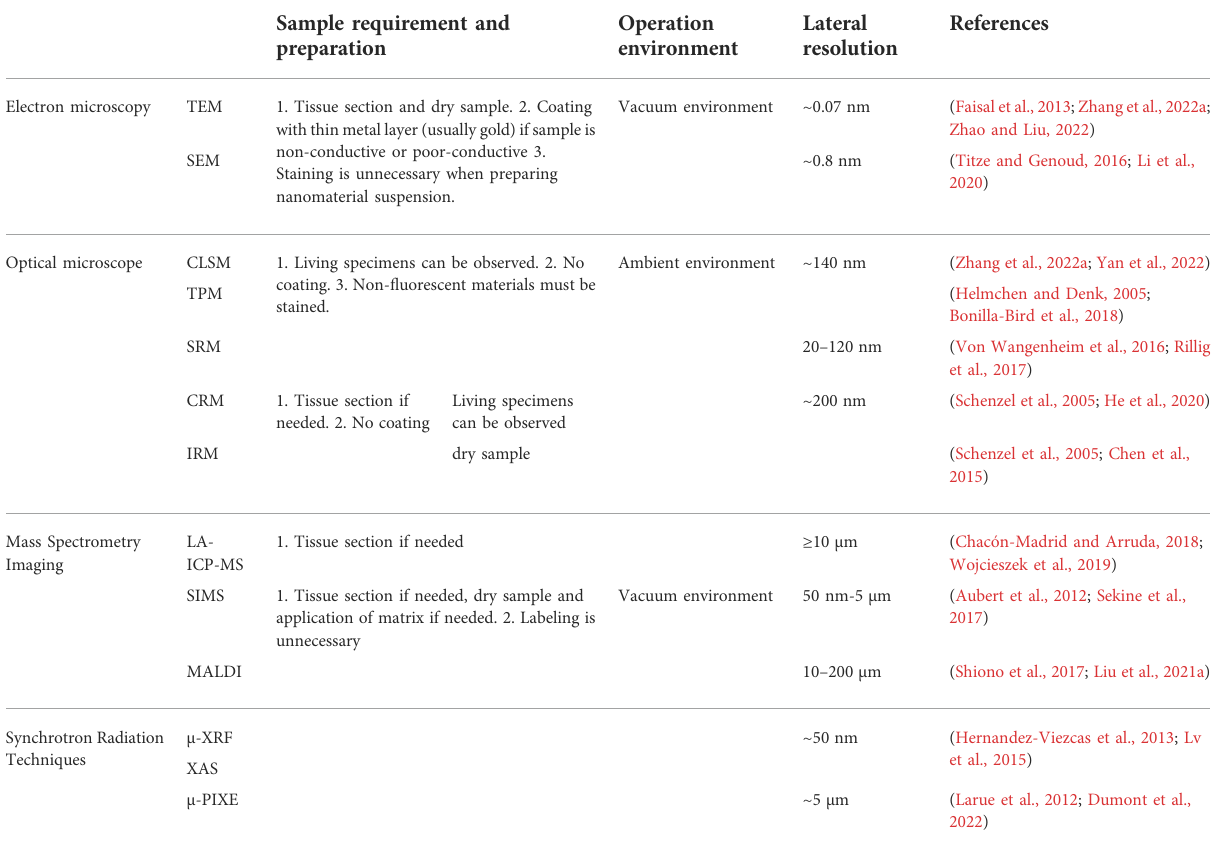
TABLE 1 Comparing of imaging tools that can be used to study interactions of nanomaterials with